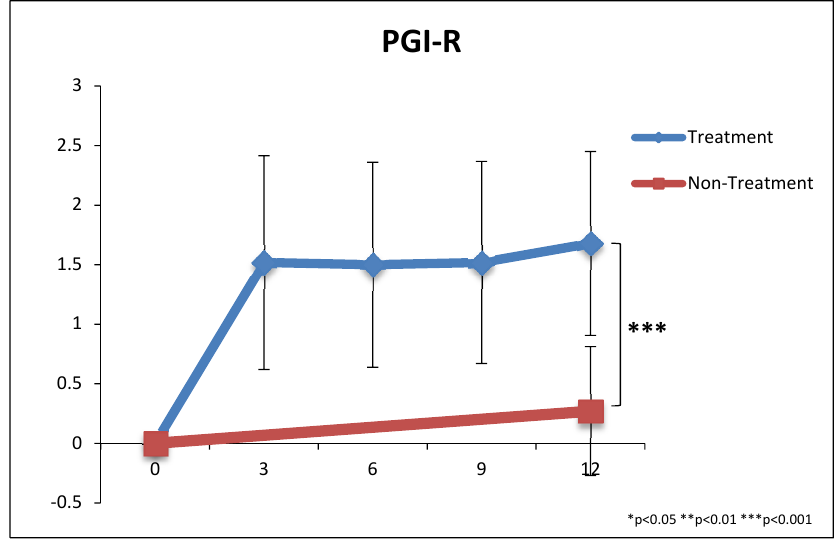
Figure 13. PGI ‐ R2 scores during the study. The scale goes from − 3 (much worse) to 0 (no change) to 1 (slightly better), 2 (better), 3 (much better). Error bars represent standard deviations.